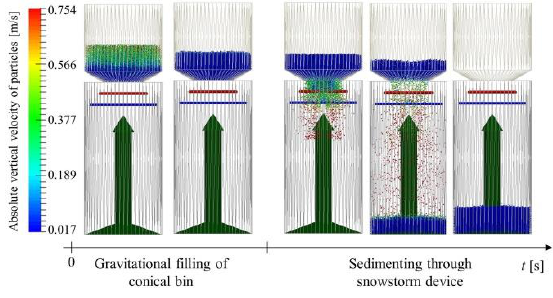
Fig. 3. Steps of DEM simulation